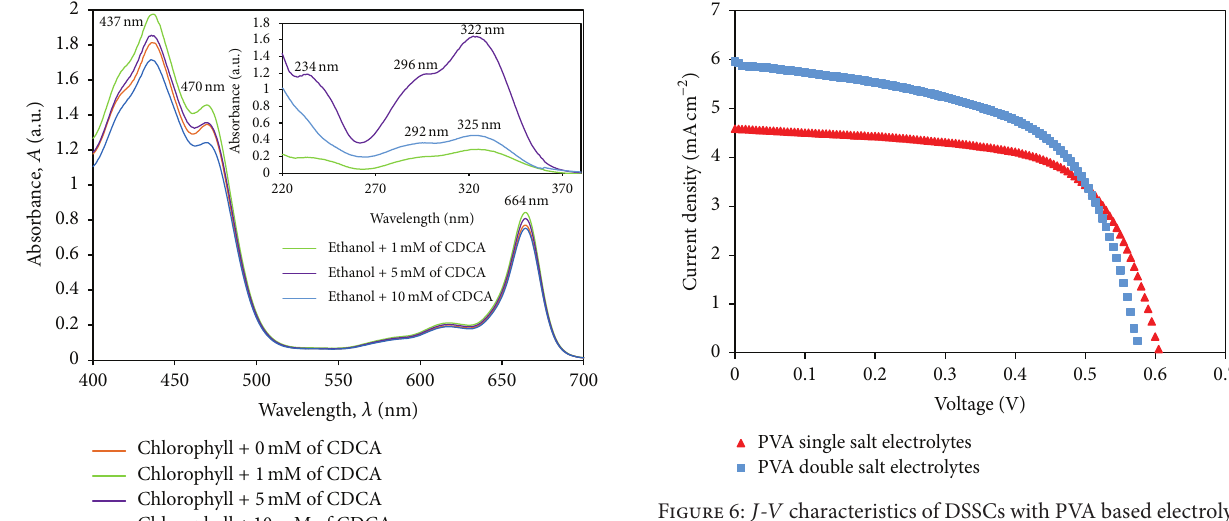
Figure 6: 𝐽 - 𝑉 characteristics of DSSCs with PVA based electrolytes containing single and double